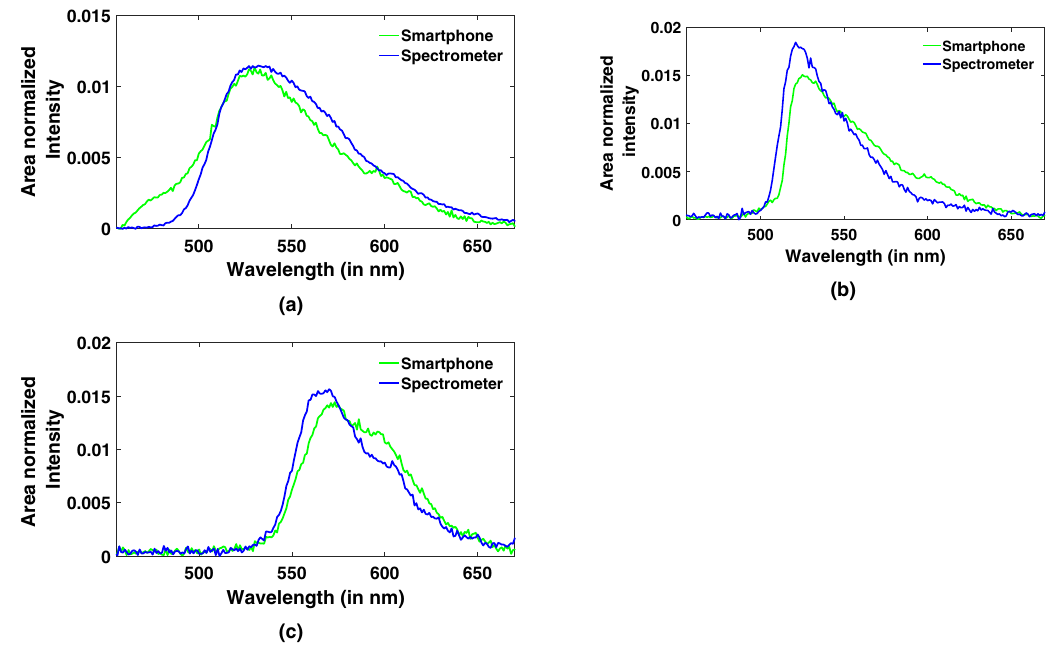
Figure 5. Comparison between smartphone and spectrometer for fluorescence spectra of ( a ) FAD, ( b ) Fluorescein, and ( c )